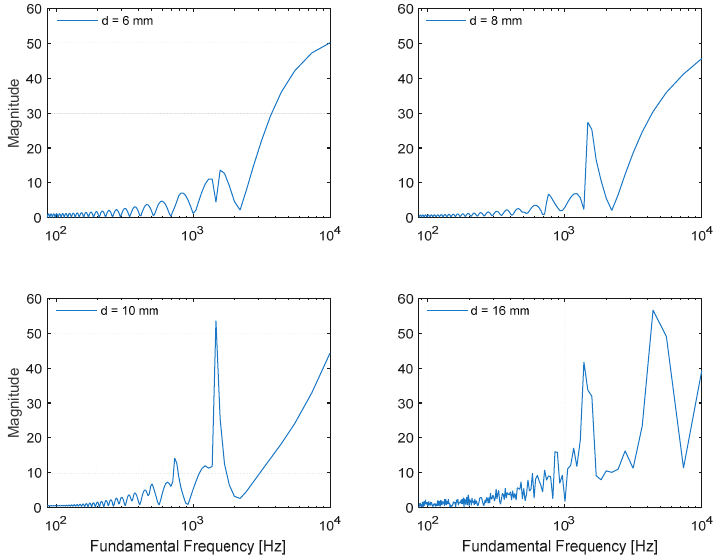
Figure 7. Plot matrix for simulated fundamental frequency of cylindrical pipe ( l = 117.7 mm, h = 3 mm, and w = 8 mm) with selected